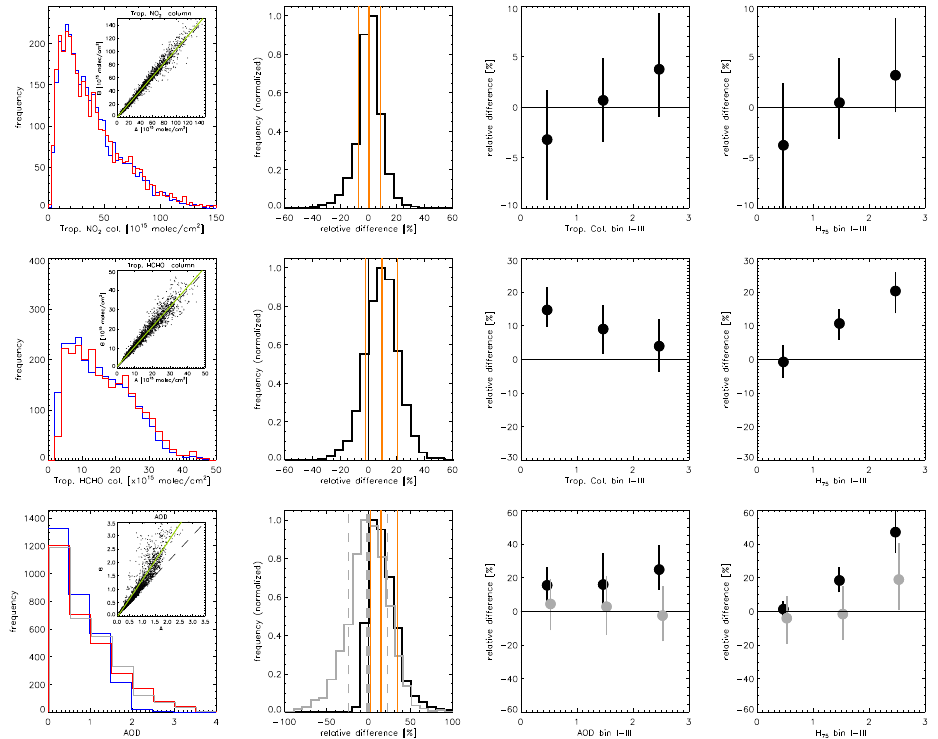
Figure 10. Statistics of column density retrievals. The three rows refer to tropospheric column densities of NO 2 , HCHO and aerosols respectively. Left column: frequency distributions obtained with method A (blue) and B (red). Second column: frequency distribution of relative differences (B minus A). Lines in orange indicate the quartiles. Column 3: relative difference sorted as a function of the tropospheric column density (AOD for row 3) where the three bins refer to the lowest 25%, middle 50% and highest 25% respectively. Column 4: similar to column 3, but here sorted as a function of the profile height ( H 75 ). The grey line on the bottom row refers to AODs from AERONET. The relative differences indicated in grey (bottom row, columns 2–4) refer to method B minus